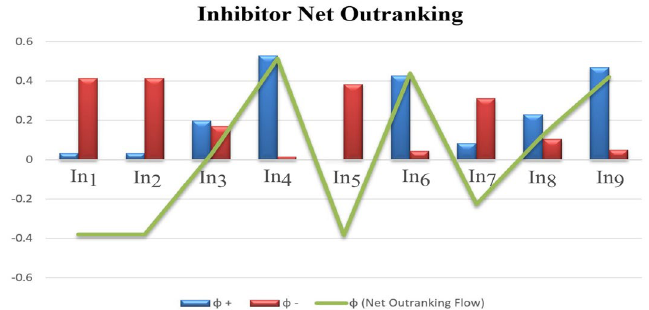
Figure 5. Inhibitor Net Outranking Flow with Positive and Negative